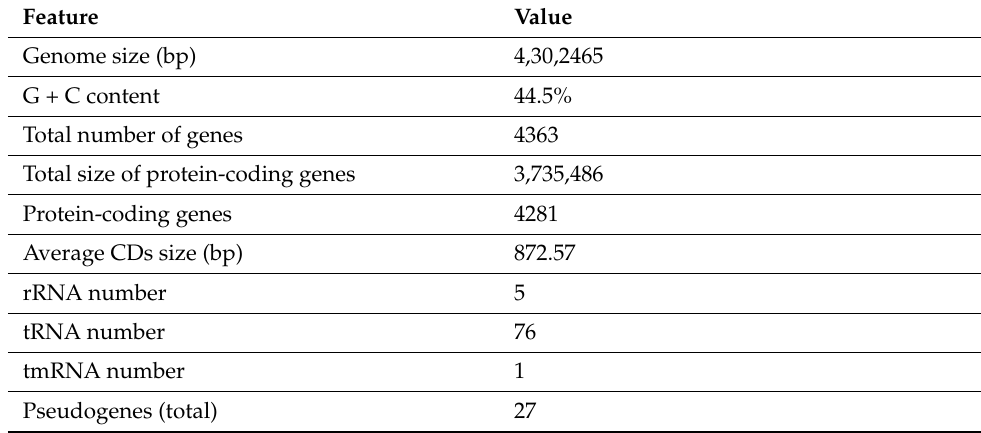
Table 1. The general genome feature of Bacillus subtilis .